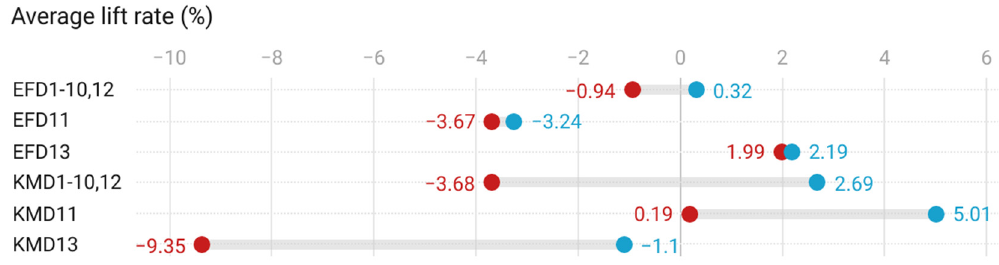
Figure 13. Average increase in the R 2 of the model (binning encoding).